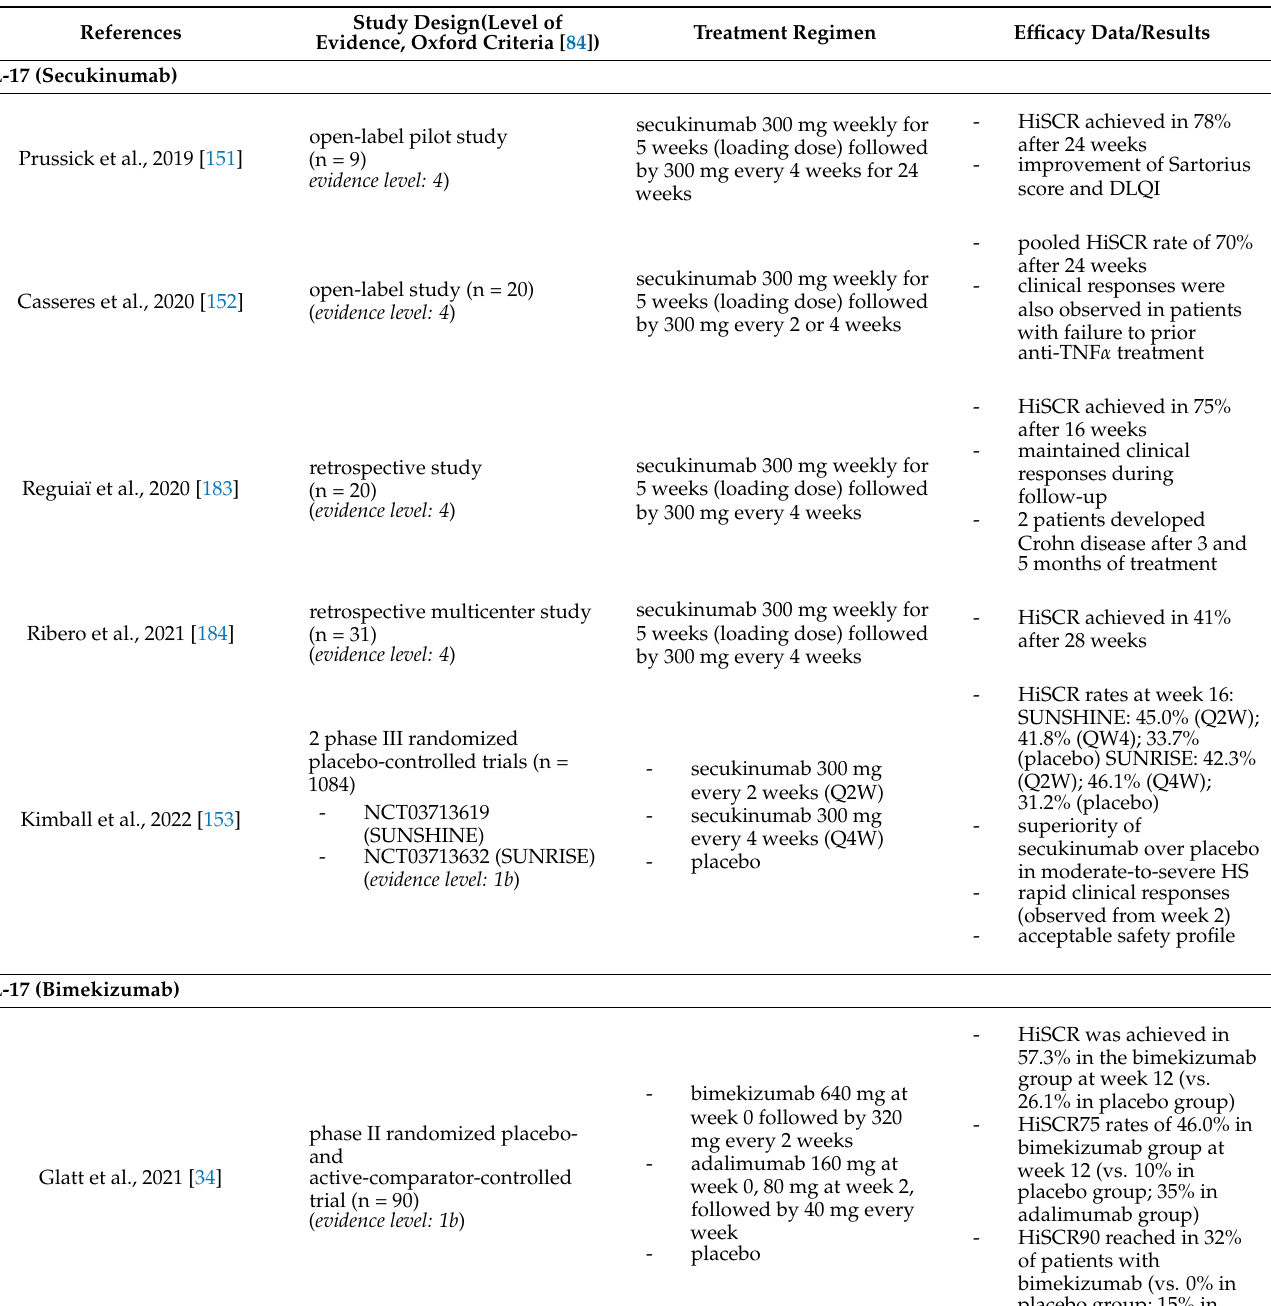
Table 5. Results of clinical studies evaluating new treatment approaches for HS (only completed studies with reported study